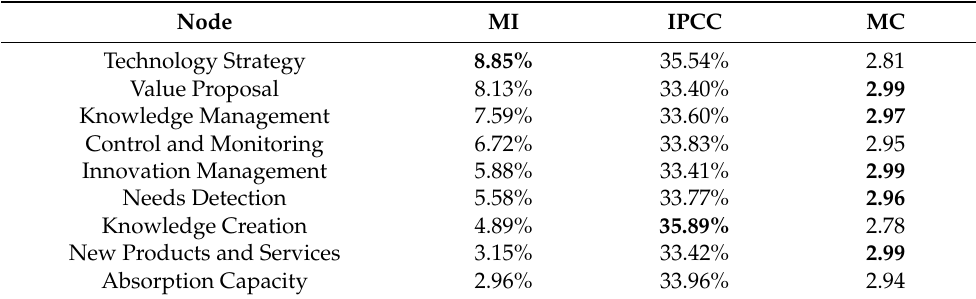
Table 3. Marginal improvement variables.